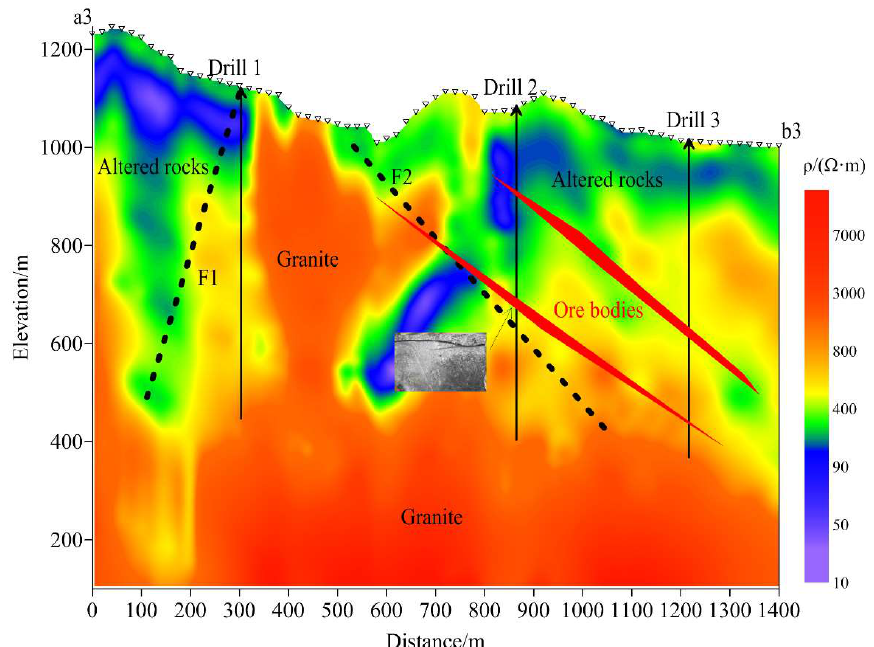
Figure 6. Multi-channel curves of L3 ( a ) and L4 ( b ).